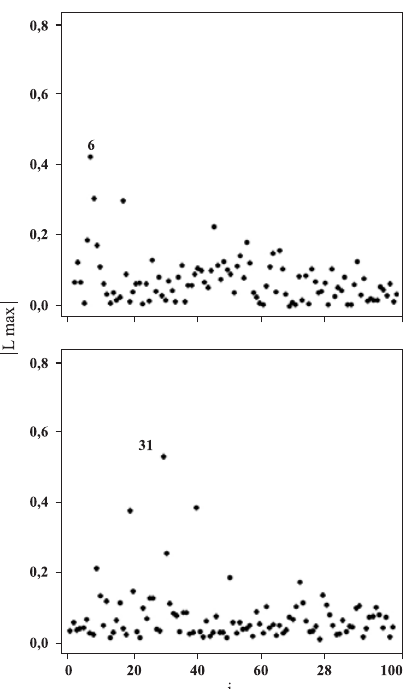
Figure 6. Index plot of |L | for simulated data max using the Matérn 0-10-20 (left side) and 0-10- 60 Figure 8. Index plot of |L | for simulated data (right side) covariance function, with = 0.7. max using the Matérn 0-10-20 (left side) and 0-10-60 (right side) covariance function, with k =